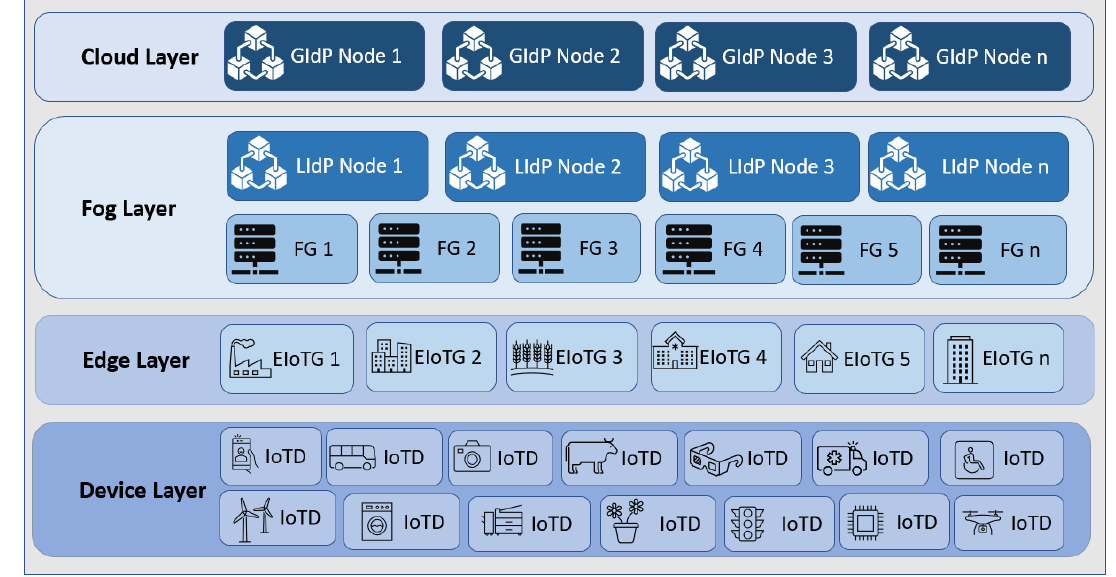
Figure 3. Overall architecture of the proposed model.